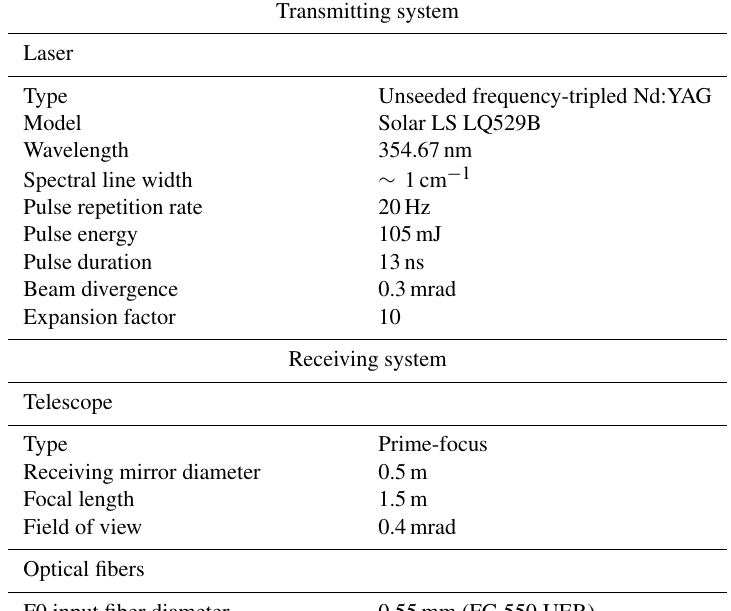
Table 1. Main technical parameters of the IMCES lidar transmitting, receiving, and data acquisition